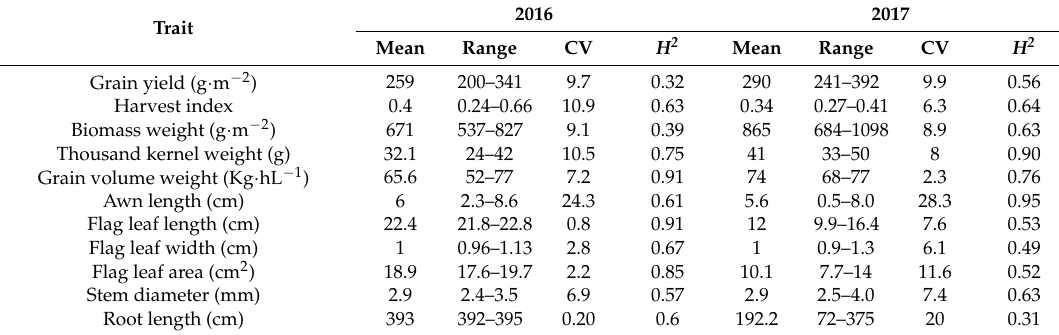
Table 2. Phenotypic variation for grain yield and yield-related traits with best linear unbiased predictor values, range, percentage of coefficient of variation (CV), and broad sense heritability ( H 2 ) of 123 synthetic hexaploid wheat grown in two seasons (2016 and 2017) in Konya,